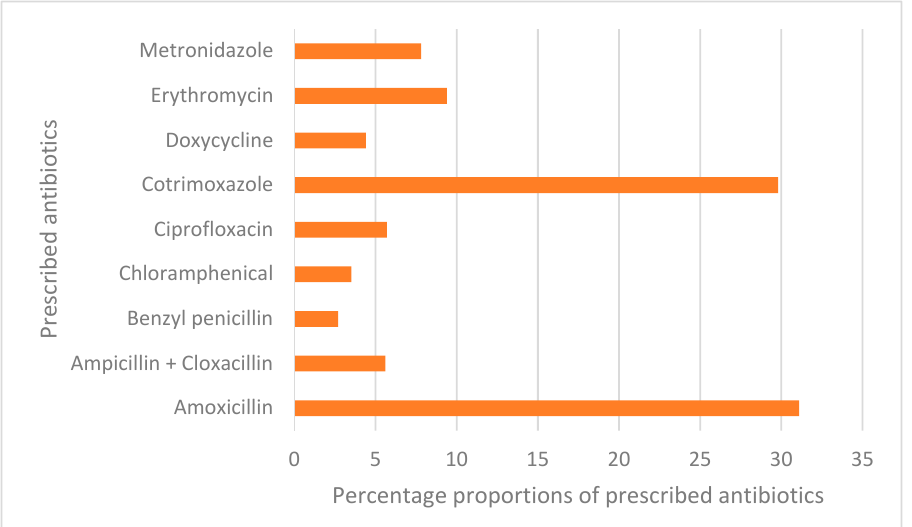
Figure 2. Commonly prescribed